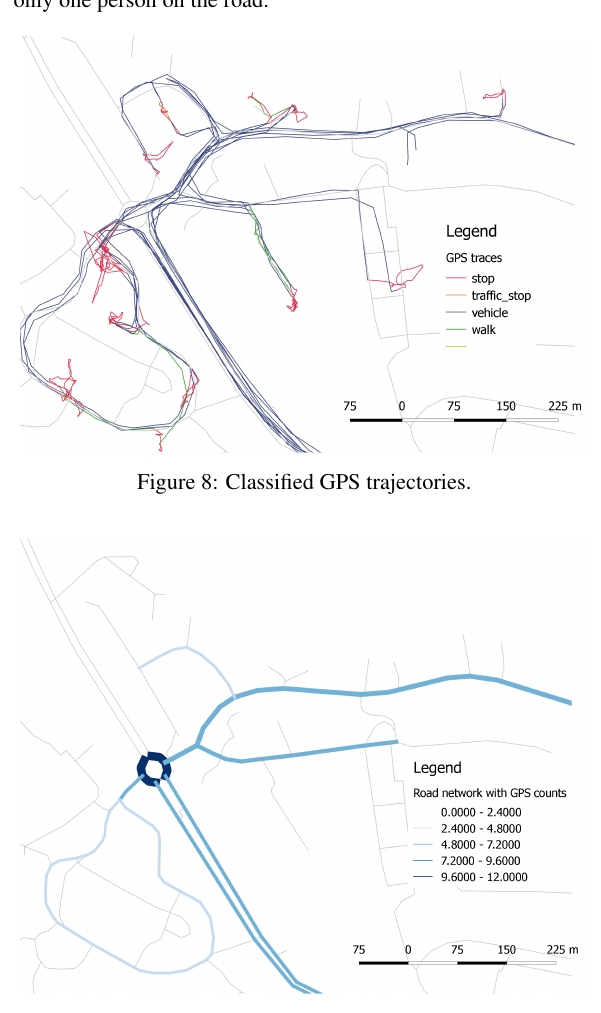
Figure 9: Road link generalisation.